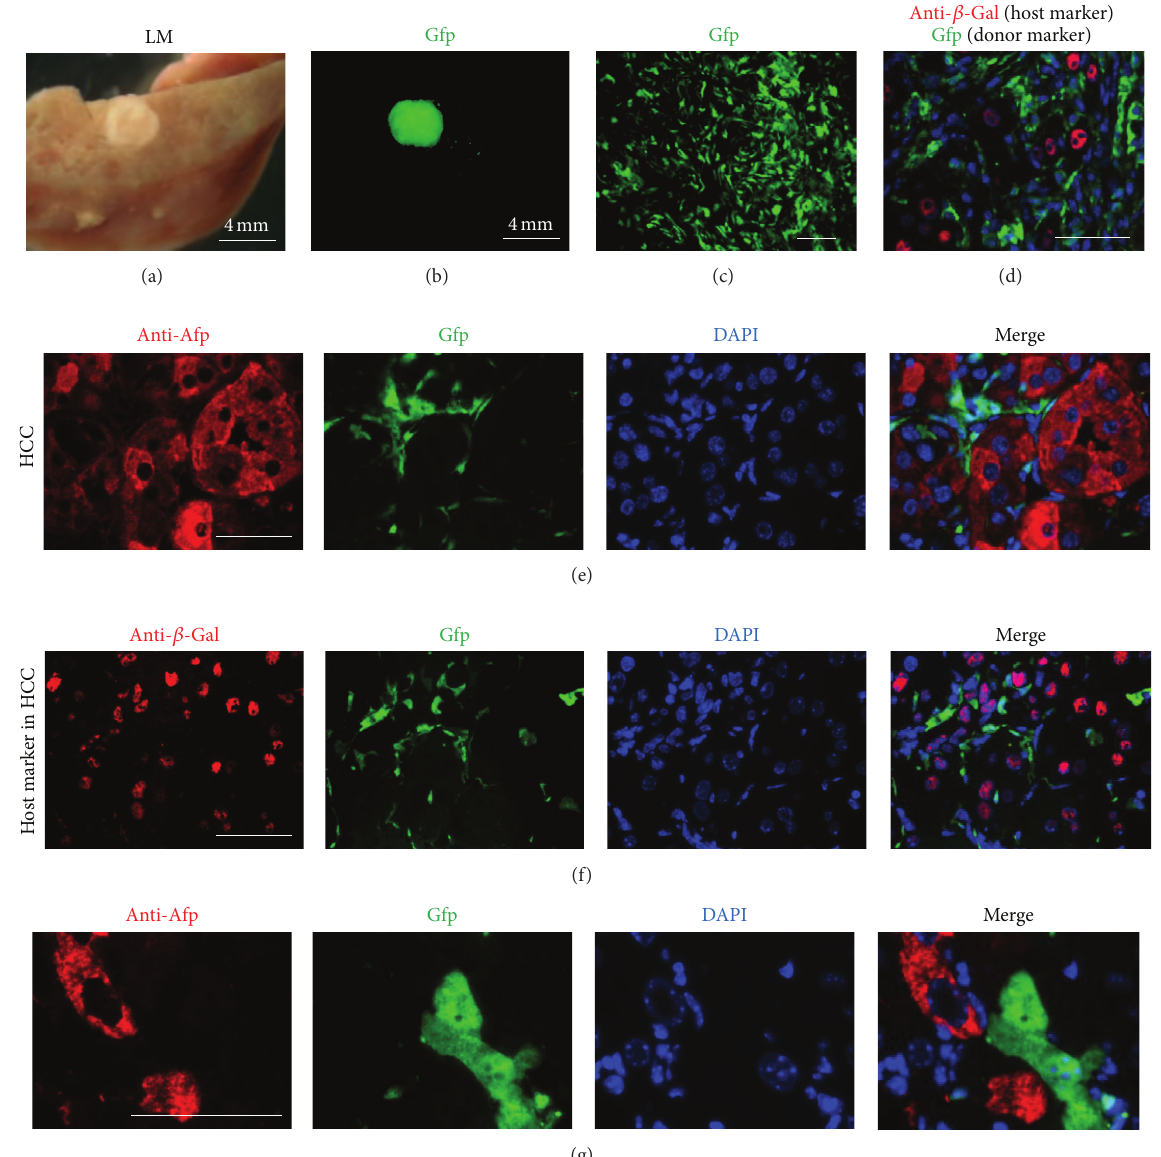
Figure 4: Identification of the cellular origins in liver tumors. Images of gross liver specimens with a tumor (a) and immunofluorescence detection of donor BMC-derived Gfp + nodules (b) in 8-month-old mice of Group 3 as shown in (a) and (b). Expression of Gfp (green) (c) and 𝛽 -Gal (red) (d) was observed in tumor sections. No coexpression of Gfp and anti- 𝛽 -Gal was found in the tumor (e). Serial liver sections were stained with antibodies against Afp (tumor marker; red) (f) and the host marker ( 𝛽 -Gal; red). Afp-positive cells confirmed hepatic carcinoma. A higher magnification of the tumor cells stained for Afp revealed that the donor-derived hepatocytes expressing Gfp (green) were negative for Afp (red) (g). Scale bars are 100 𝜇 m except for (a) and (b)